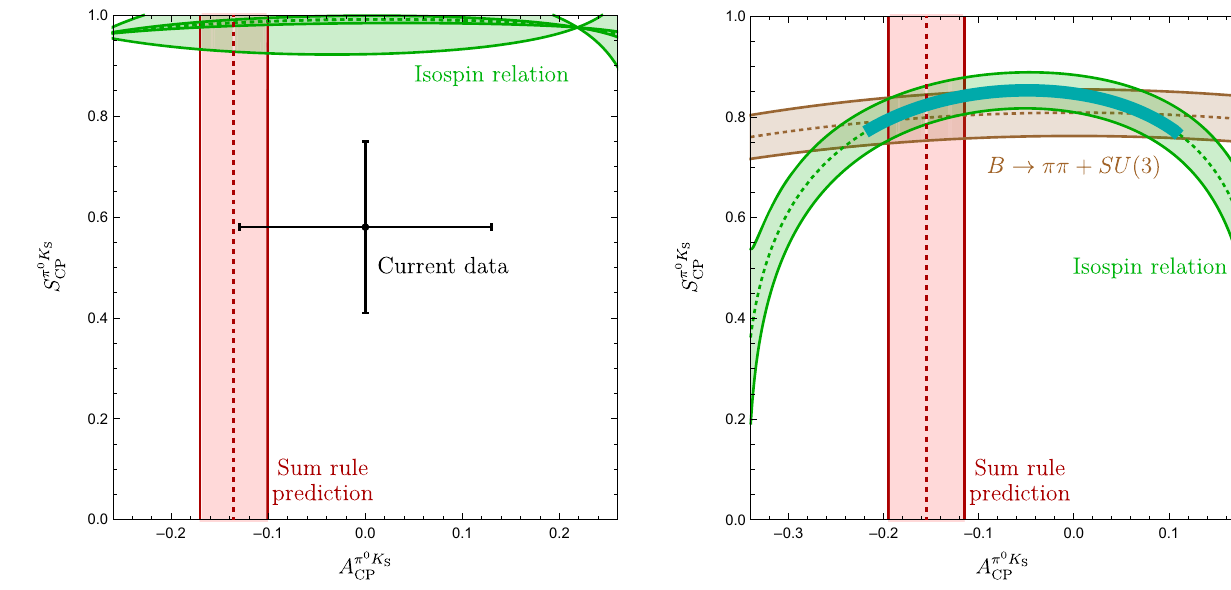
→ π 0 K 0 ) by 2 . 5 σ gives a picture consistent Fig. 9 Reducing B r ( B 0 d with the SM, where the dark part agrees perfectly with the φ ± constraint in Eq.